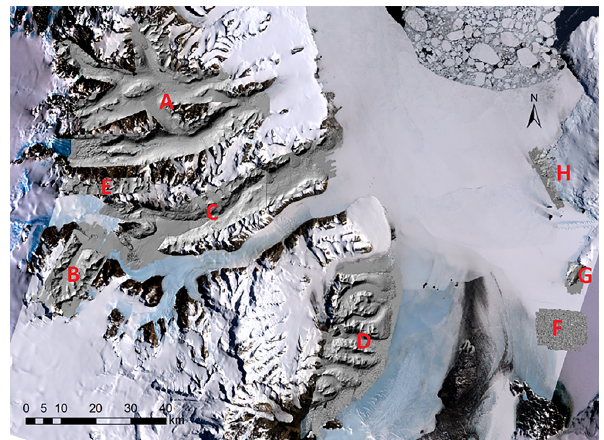
Figure 8. Shaded relief maps of the McMurdo Dry Valleys based on aerial lidar surveys conducted from December to January 2014– 2015. A is the northern valleys of Victoria, Barwick, McKelvey, and Wright with adjacent valleys; B is Beacon Valley and surround- ings; C is Taylor Valley and surroundings; and D is the southern Dry Valleys of Garwood, Miers, Marshall, and adjacent valleys. E is a section of the Asgard ranges, F is Pegasus Airfield, G is the Mc- Murdo Station area, and H is Capes Royds and Evans. Base map is the Landsat Image Mosaic of Antarctica (Bindschadler et al.,